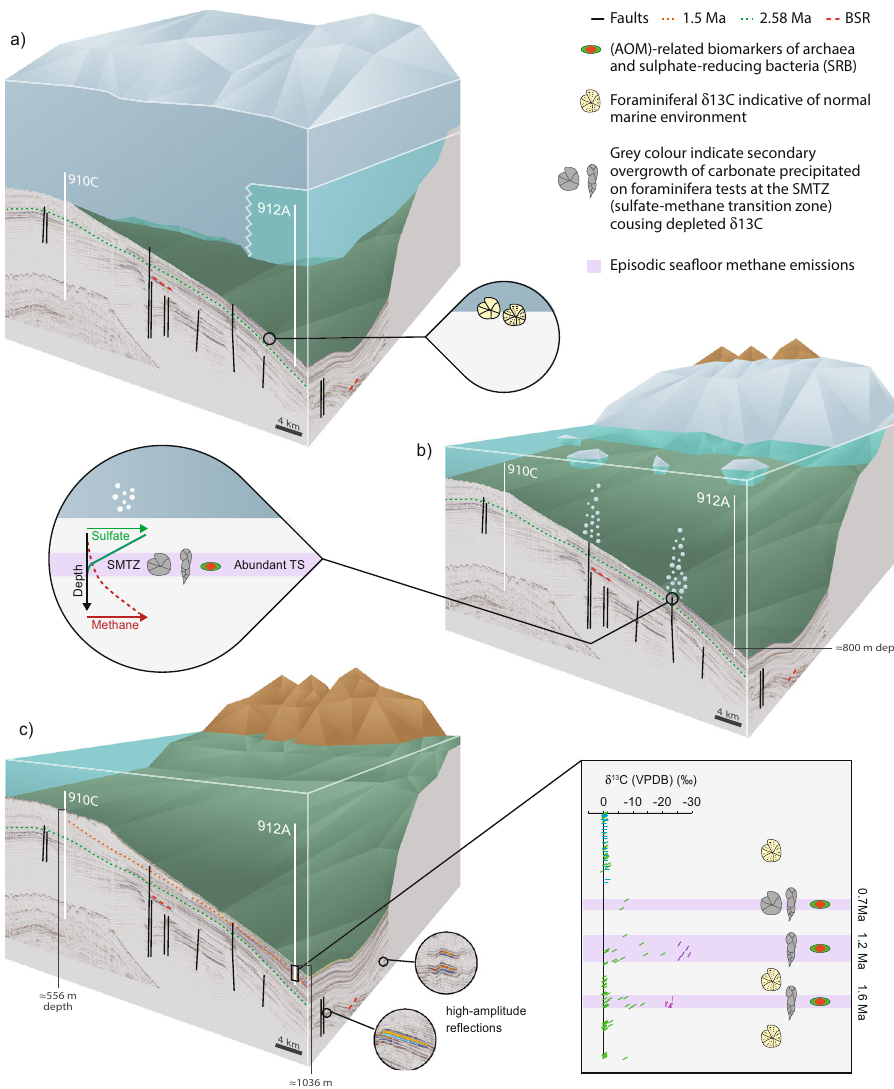
Fig. 5 Mid-Pleistocene methane release on the Yermak Plateau, NW Svalbard. a Conceptual model of glacial intensi fi cation (~1.6 – 1.5 Ma) and MPT ice sheet grounding (~1.0 to ~0.8 Ma). The locations of ODP Sites 910 and 912 are indicated. b Upon glacier retreat, hydrate dissociation and fault reactivation contributed to intense methane release at the sea fl oor during ME I, ME II and ME III. c Present-day environment in the study area, where the stable isotope compositions ( δ 13 C) of foraminifera and biomarker analysis from ODP Hole 912A sediments indicate evidence of past methane release (not to scale). High- amplitude re fl ections in seismic data indicate methane in the sediments below the Gas Hydrate Stability Zone